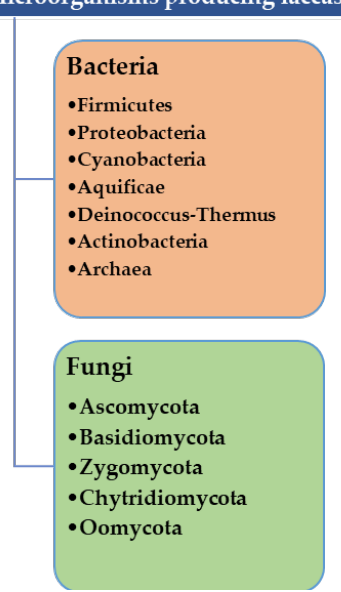
Figure 2. Phyla of micro-organisms producing laccases (authors creation).